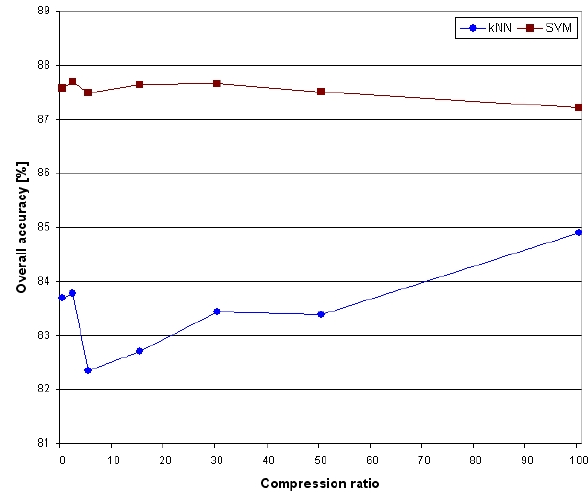
Figure 5. Overall classification accuracy